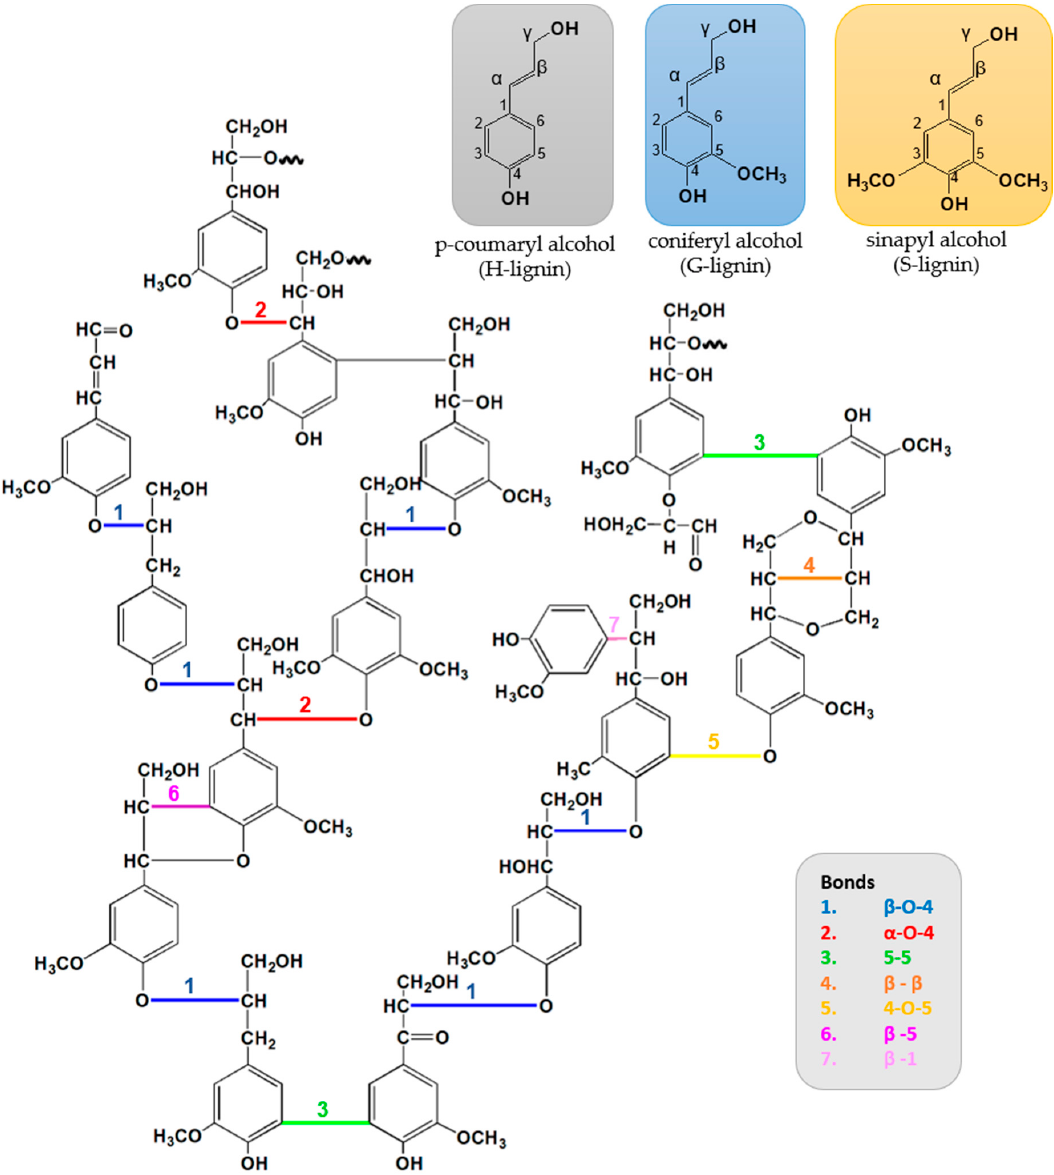
Figure 4. Chemical structure of monolignols, softwood lignin, and the type bonding formed between the monolignols during the polymerization process. Adapted from Windeisen [72] with permission. Copyright 2012,